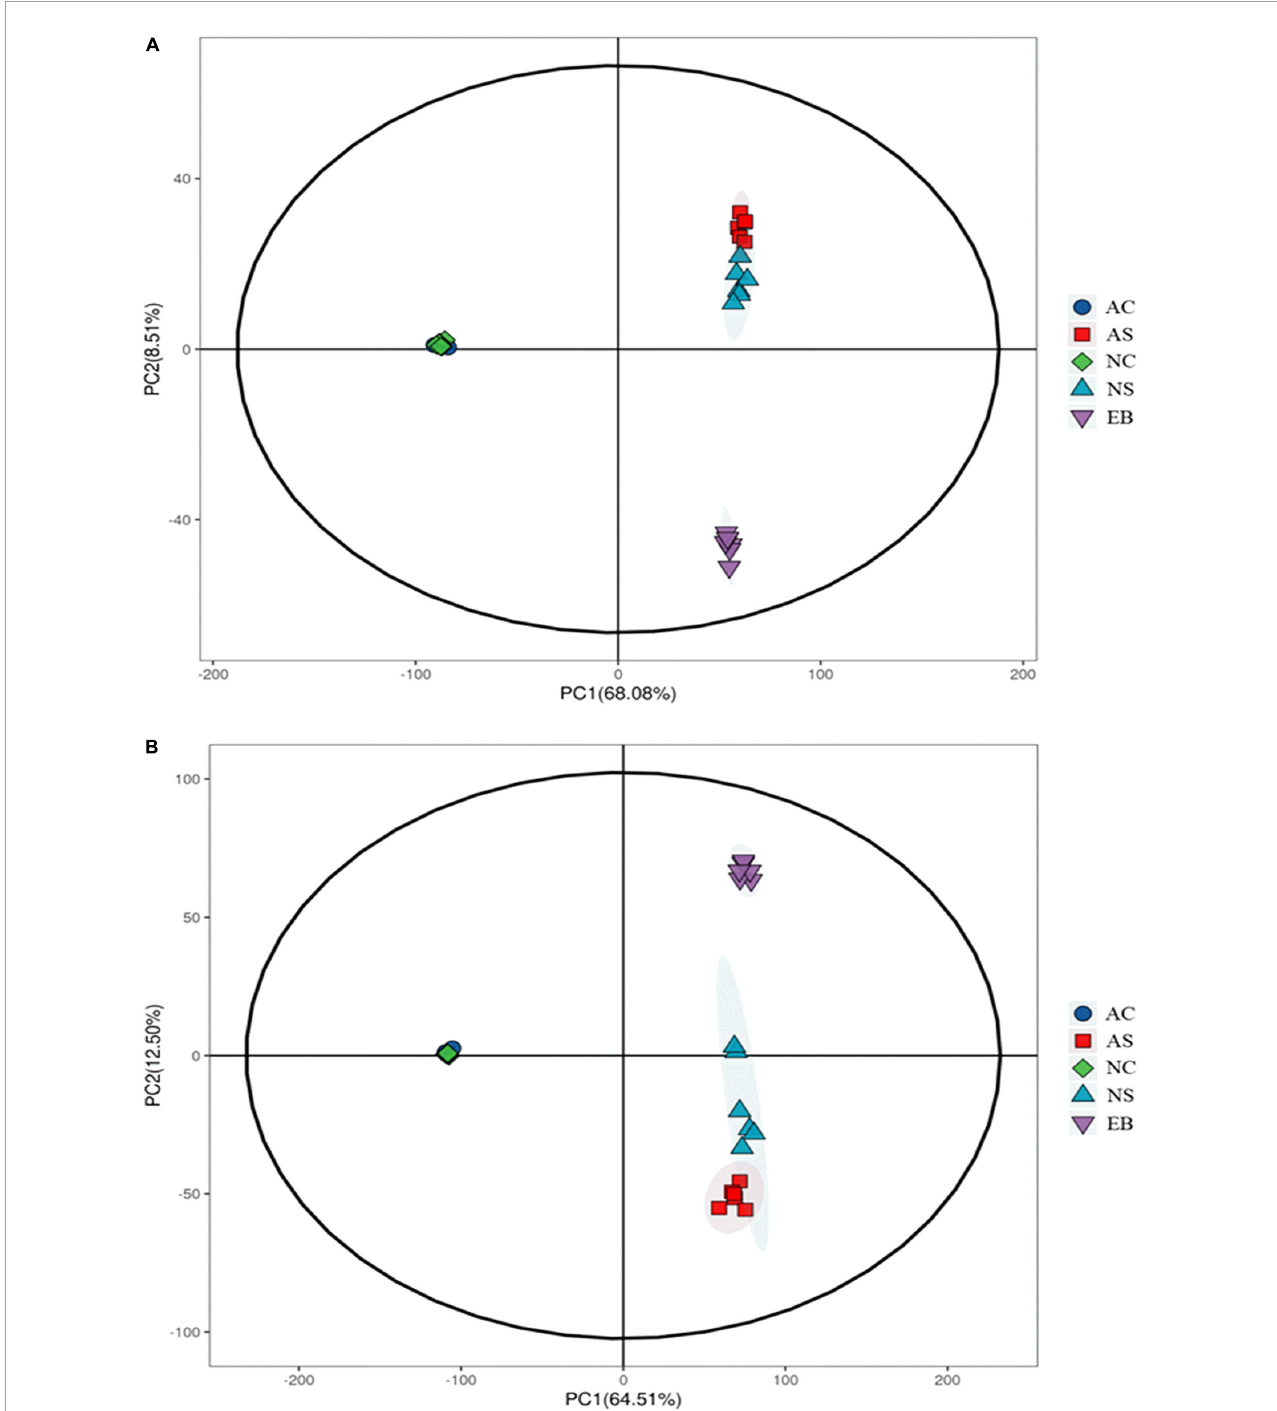
FIGURE3 PCA score plots of positive (A) and negative (B) metabolite profiling data of Polygonati Rhizoma fermented using Lactiplantibacillus plantarum under aerobic and anaerobic conditions. AC, aerobic fermentation with L. plantarum cells; NC, anaerobic fermentation with L. plantarum cells; AS, aerobic fermentation supernatants; NS, anaerobic fermentation supernatants; EB, extracts of Polygonati Rhizoma before